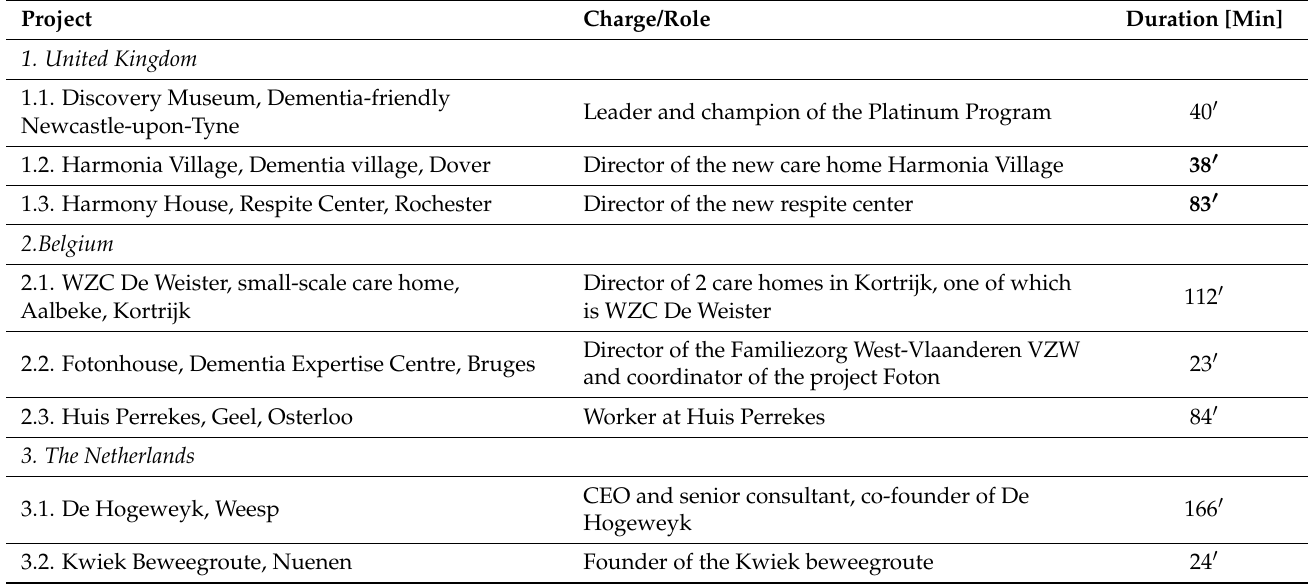
Table 4. List of interviews. Source: Own